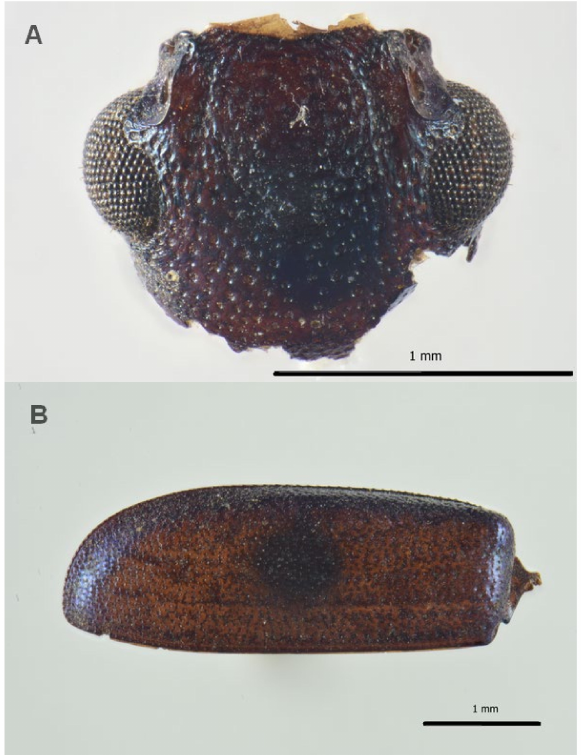
Figure 4. Coleoptera remains associated to the burial site of Saint Davino Armeno: ( A ) Necrobia sp., head, frontal view; ( B ) Necrobia sp., left elytra; note that the lack of bristles is due to the taphonomic